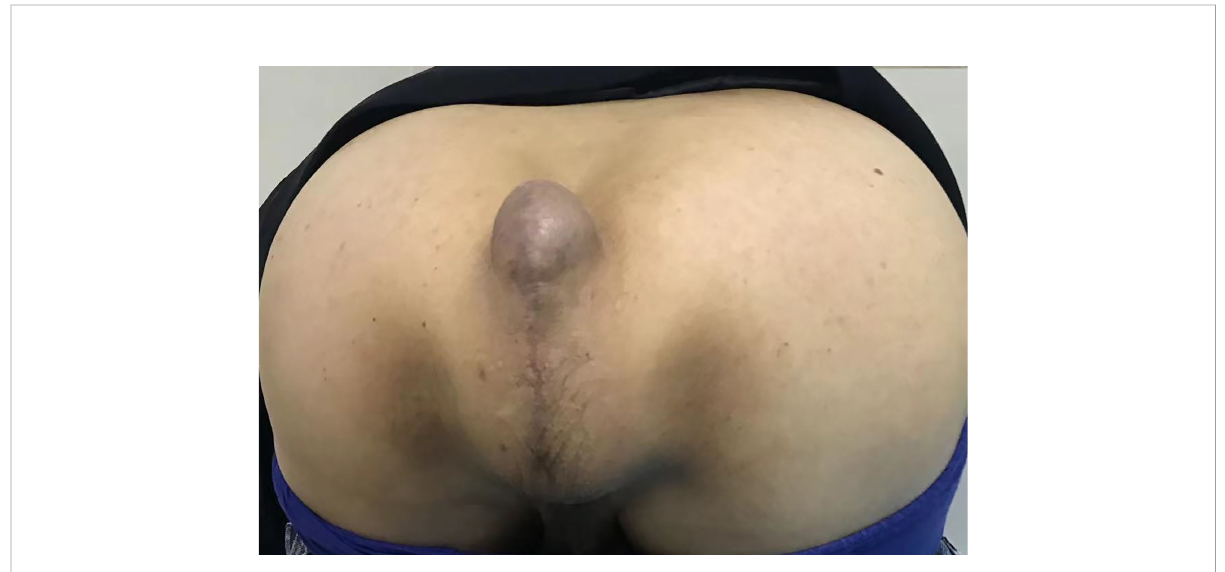
FIGURE 1 Image of the hernia